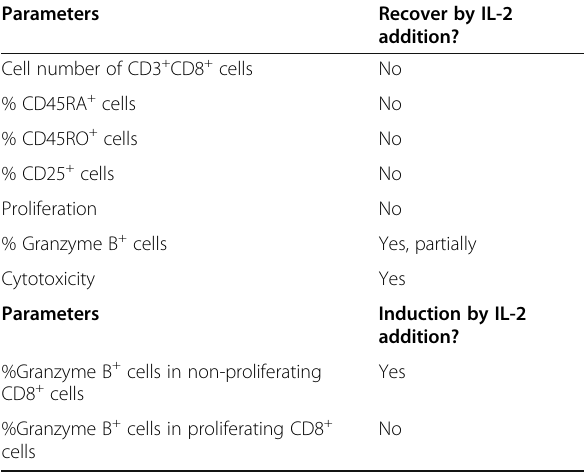
Table 1 IL-2 addition to cultures upon exposure to chrysotile B Parameters